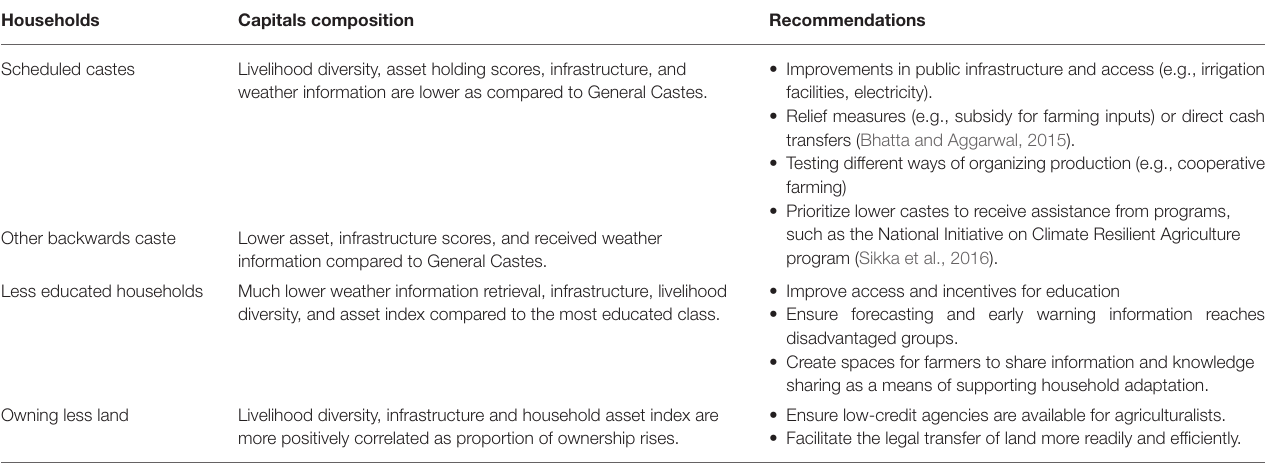
TABLE 8 | Short-term policy recommendations across Bihar and Haryana for disadvantaged groups where household capital was observed to mediate adaptation.